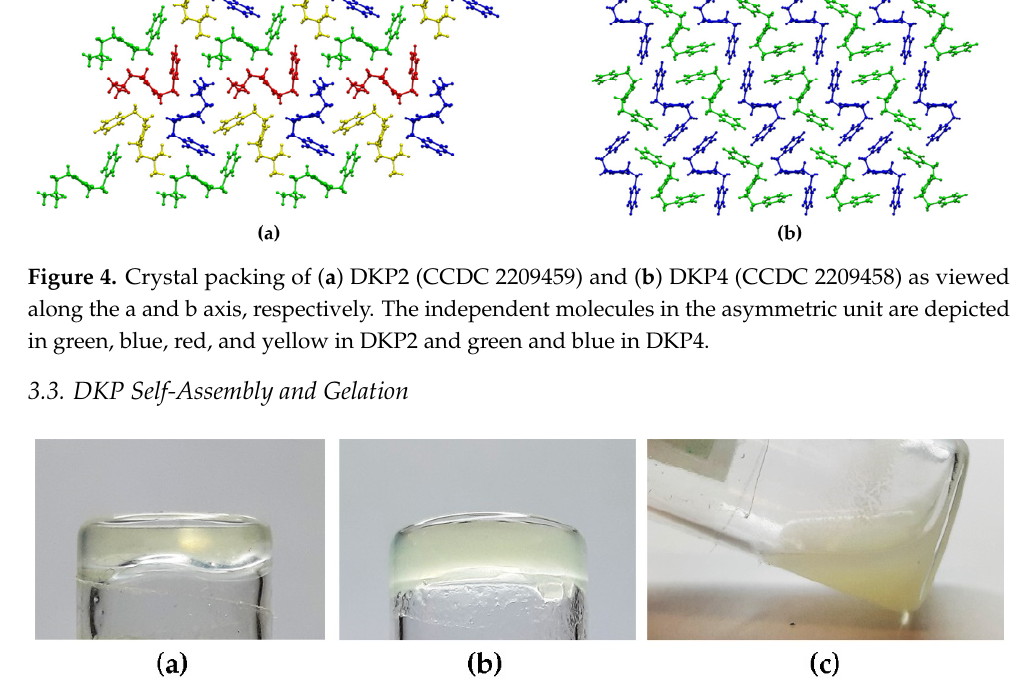
Figure 5. Photographs of inverted-tube tests to probe for the gelation ability of DKPs 1–4 in soybean oil. ( a ) DKP1; ( b ) DKP2 (or DKP3); ( c ) Table 3 . Gelation tests for DKPs 1–4. P = precipitate. G = gel . Table 3 . Gelation tests for DKPs 1–4. P = precipitate. G = gel .